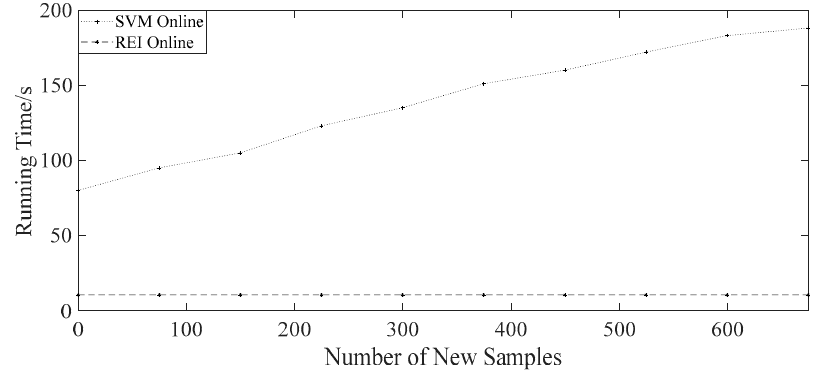
Figure 5. Running time of contrast experiment in the online learning scenario.